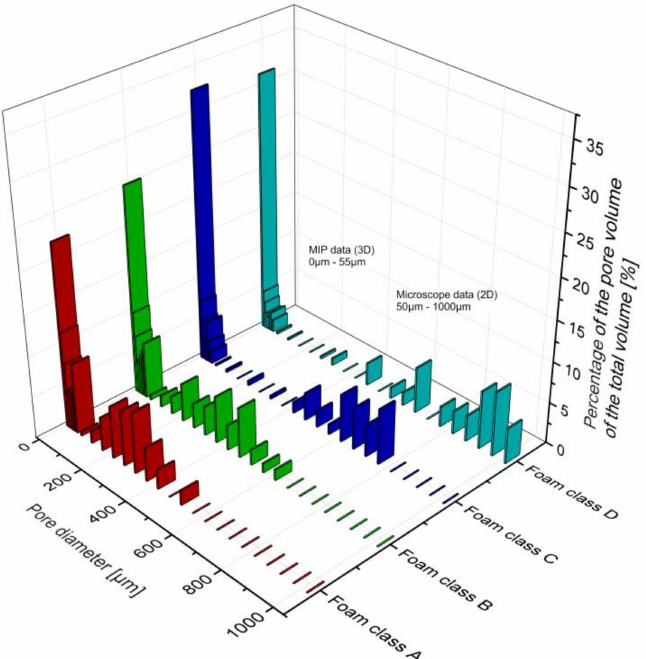
Figure 6. Pore size distribution for the foam classes A to D (as in Figure 4) ranging from 0 to 1000 µ